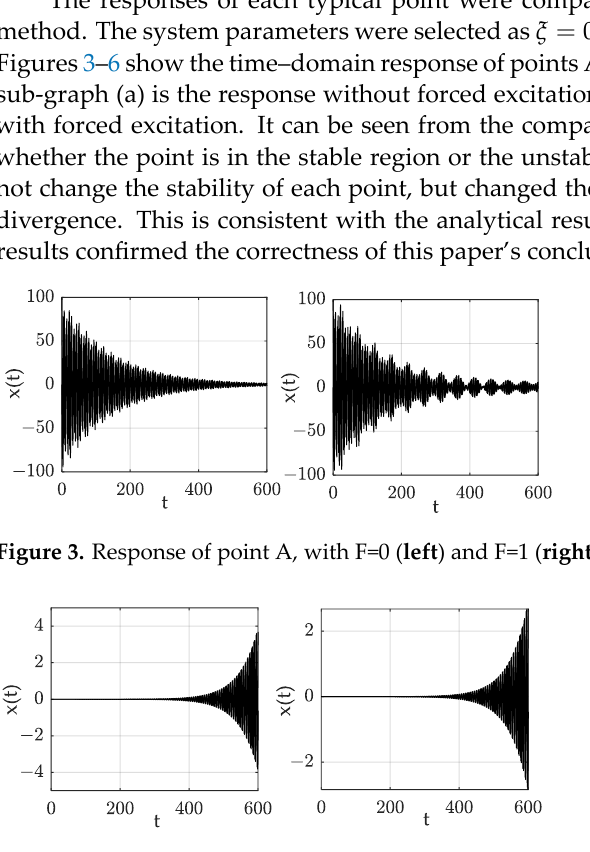
Figure 5. Response of point C, with F=0 ( left ) and F=1 ( right ). Figure 6. Response of point D, with F=0 ( left ) and F=1 ( right ). Figure 7. Response of point E, with F=0 ( left ) and F=1 ( right ).